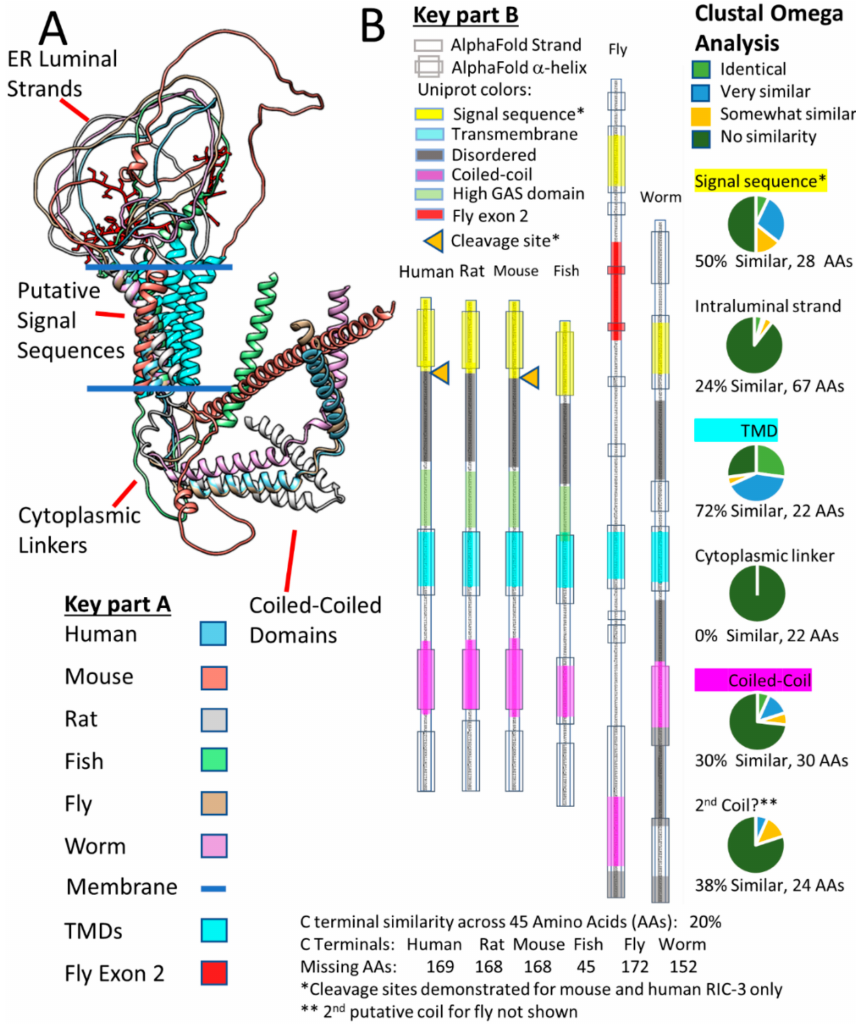
Figure 5. Alignments of pruned RIC-3 species by structures. Panel ( A ) compares AlphaFold PDBs overlayed by UCSF Matchmaker for human, mouse, rat, fish fly and worm RIC-3. The regions before the putative signal sequences and those after the coiled-coil domain(s) are removed for clarity. The putative transmembrane domains (TMDs) are colored cyan for each species to distinguish them from the putative signal sequences shown with the colors corresponding to each species. Fly exon 2 is in red with amino acid side chains shown in the ER intraluminal strand. Panel ( B ) shows the equivalent regions in linear form aligned by the beginning of the Transmembrane Domains (TMDs—shown in cyan) as defined by Uniprot annotation (https://www.uniprot.org (accessed on 21 July 2021)). The putative signal sequences (yellow), disordered sequences (gray), TMDs (cyan), and coiled-coil domains (purple) are colored according to the Uniprot annotation for each gene in addition to high GAS regions (lime) in vertebrate RIC-3s and fly exon 2 (red) in the fly ER intraluminal strand. Alpha- helices predicted by AlphaFold are shown as thicker boxes around the protein strand. C-terminal sequences beyond the second coiled-coil alpha helix (as predicted in the Uniprot annotation for each gene) are not shown and are summarized at the bottom of the figure. The rightmost column of panel ( B ) shows the results of Clustal Omega analysis (https://www.ebi.ac.uk/Tools/msa/clustalo/ (accessed on 21 July 2021)) of the protein sequences. The pie charts for each region show the proportion of identical (light green), very similar (blue), similar (orange), and regions of no similarity (dark green) along with the percentage of total similarity ([identical + very similar + similar amino acids]/total amino acids in the human RIC-3 sequence for that region). The predicted helical regions in Uniprot (Signal sequence, TMD and coiled-coil) align very well with the predicted AlphaFold structures, although AlphaFold predicts some additional short helices in fly and worm